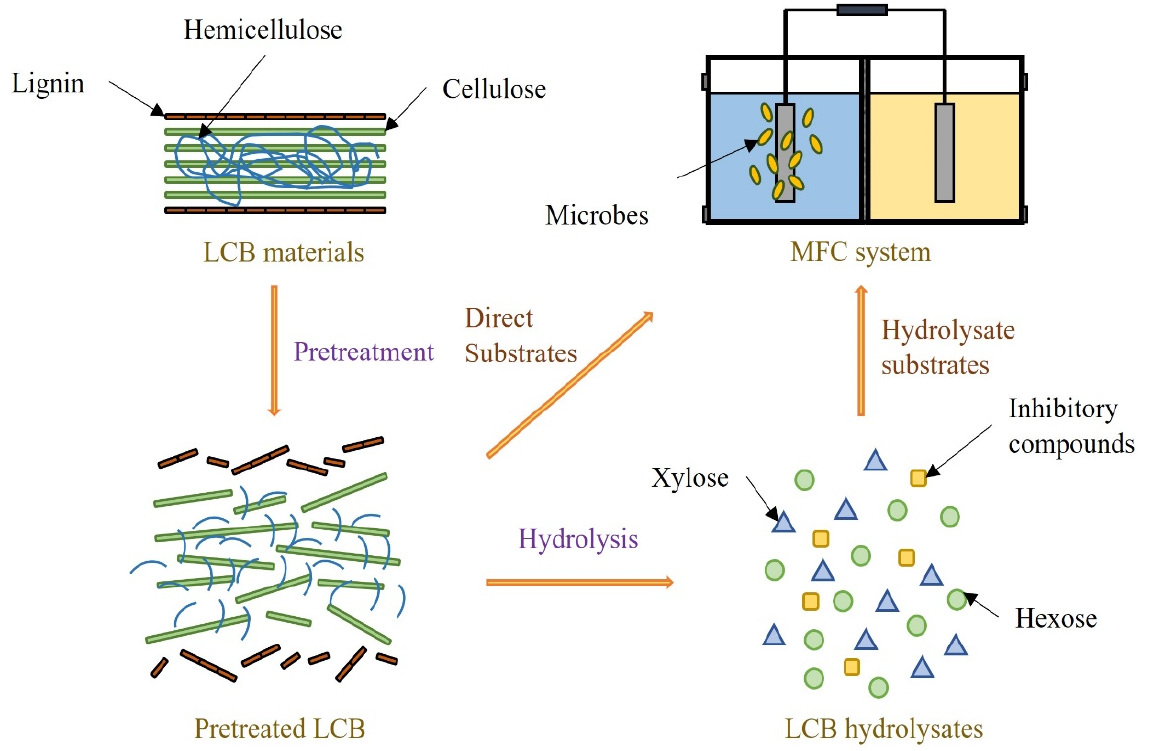
Figure 3. The utilization of LCB substrates for MFC systems.